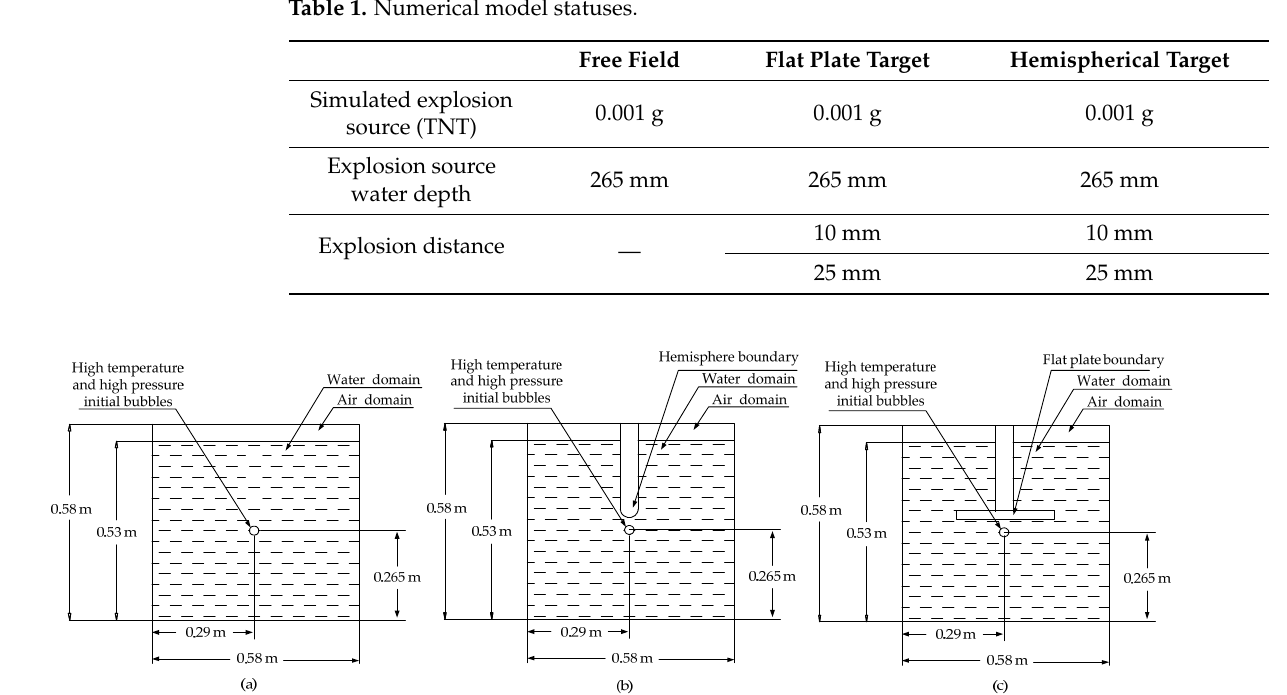
Table 1. Numerical model statuses.